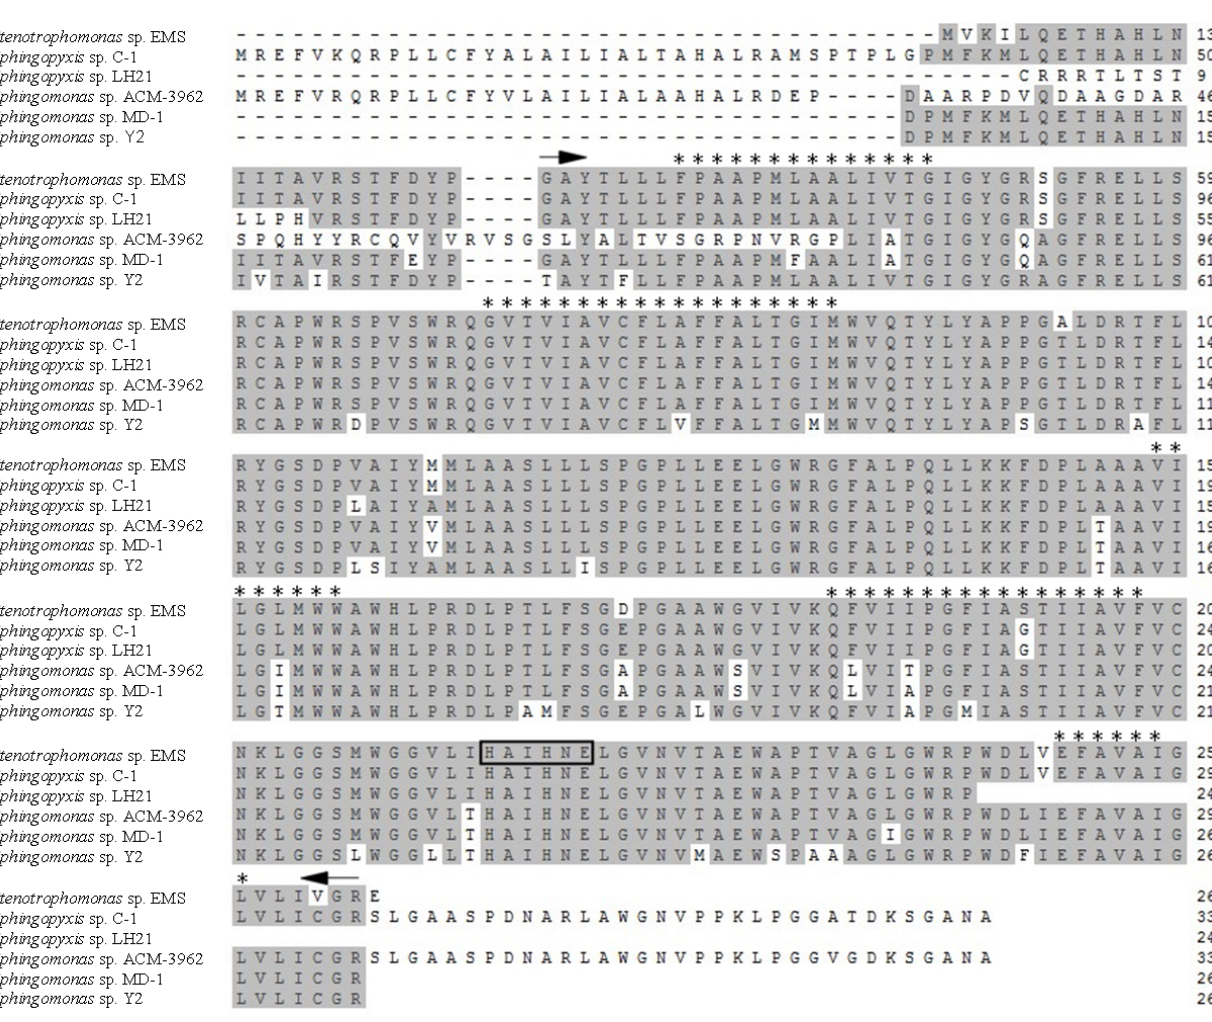
Figure 9. Alignment of the amino acid sequence of MlrA-EMS with other putative MlrAs. Grey sections indicate the identical residues in the compared sequences. The region between two black arrows is the highly conserved region in MlrA. Black frame indicates a classic zinc-bonding site. And * indicate the predicted transmembrane region with alpha